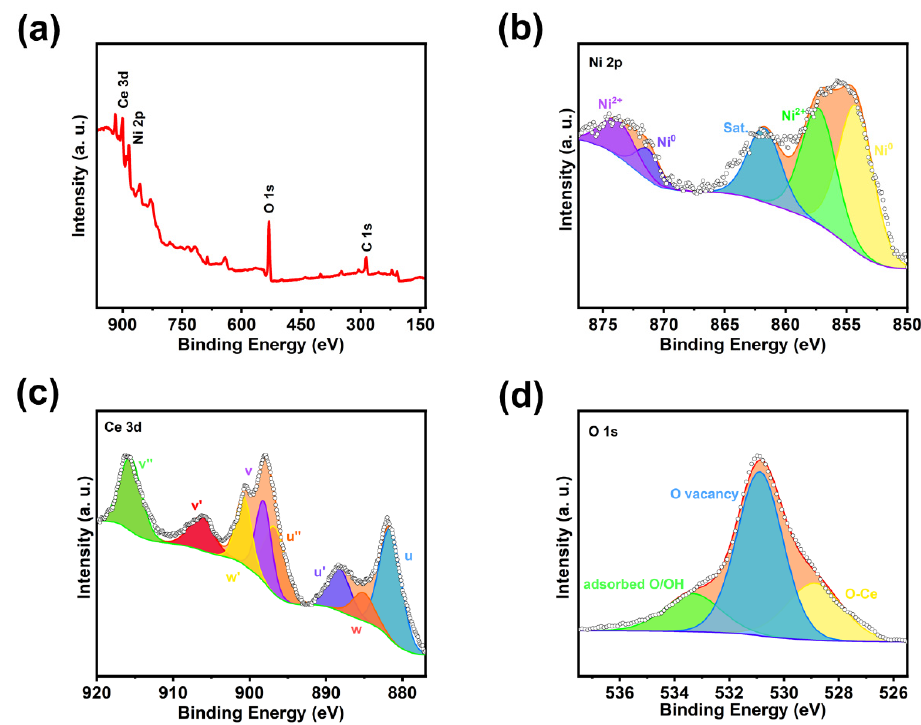
Figure 3. Compositional analyses of the resultant Ni/CeO 2 HJ-NSs. ( a ) XPS surveys, ( b – d ) high-resolution XPS spectra of ( b ) Ni 2p, ( c ) Ce 3d, and ( d ) O 1s.